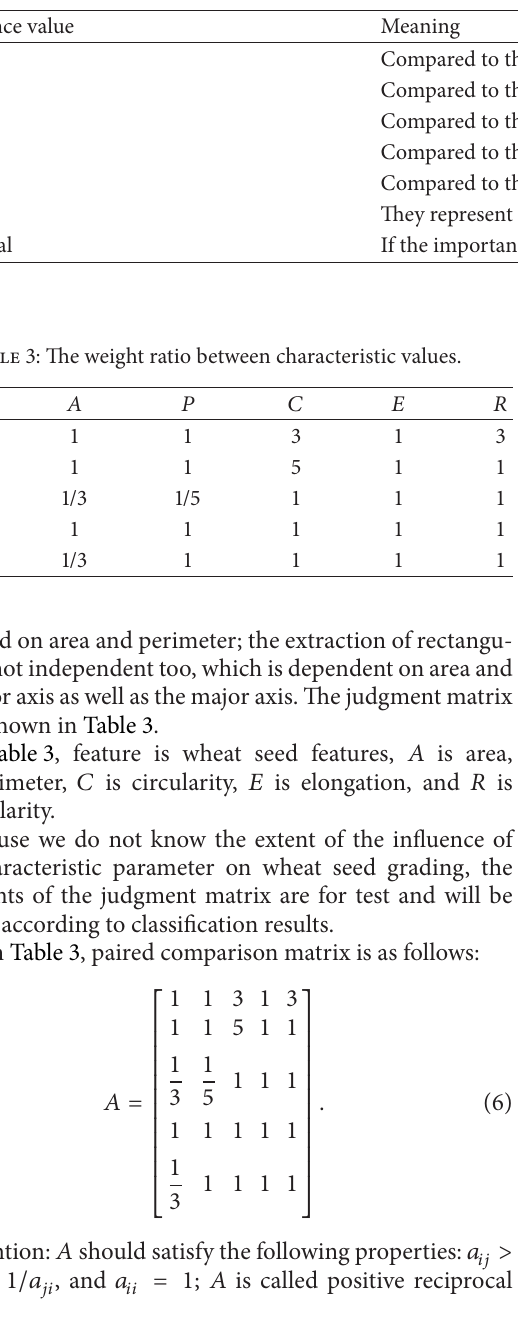
Table 2: Importance value.